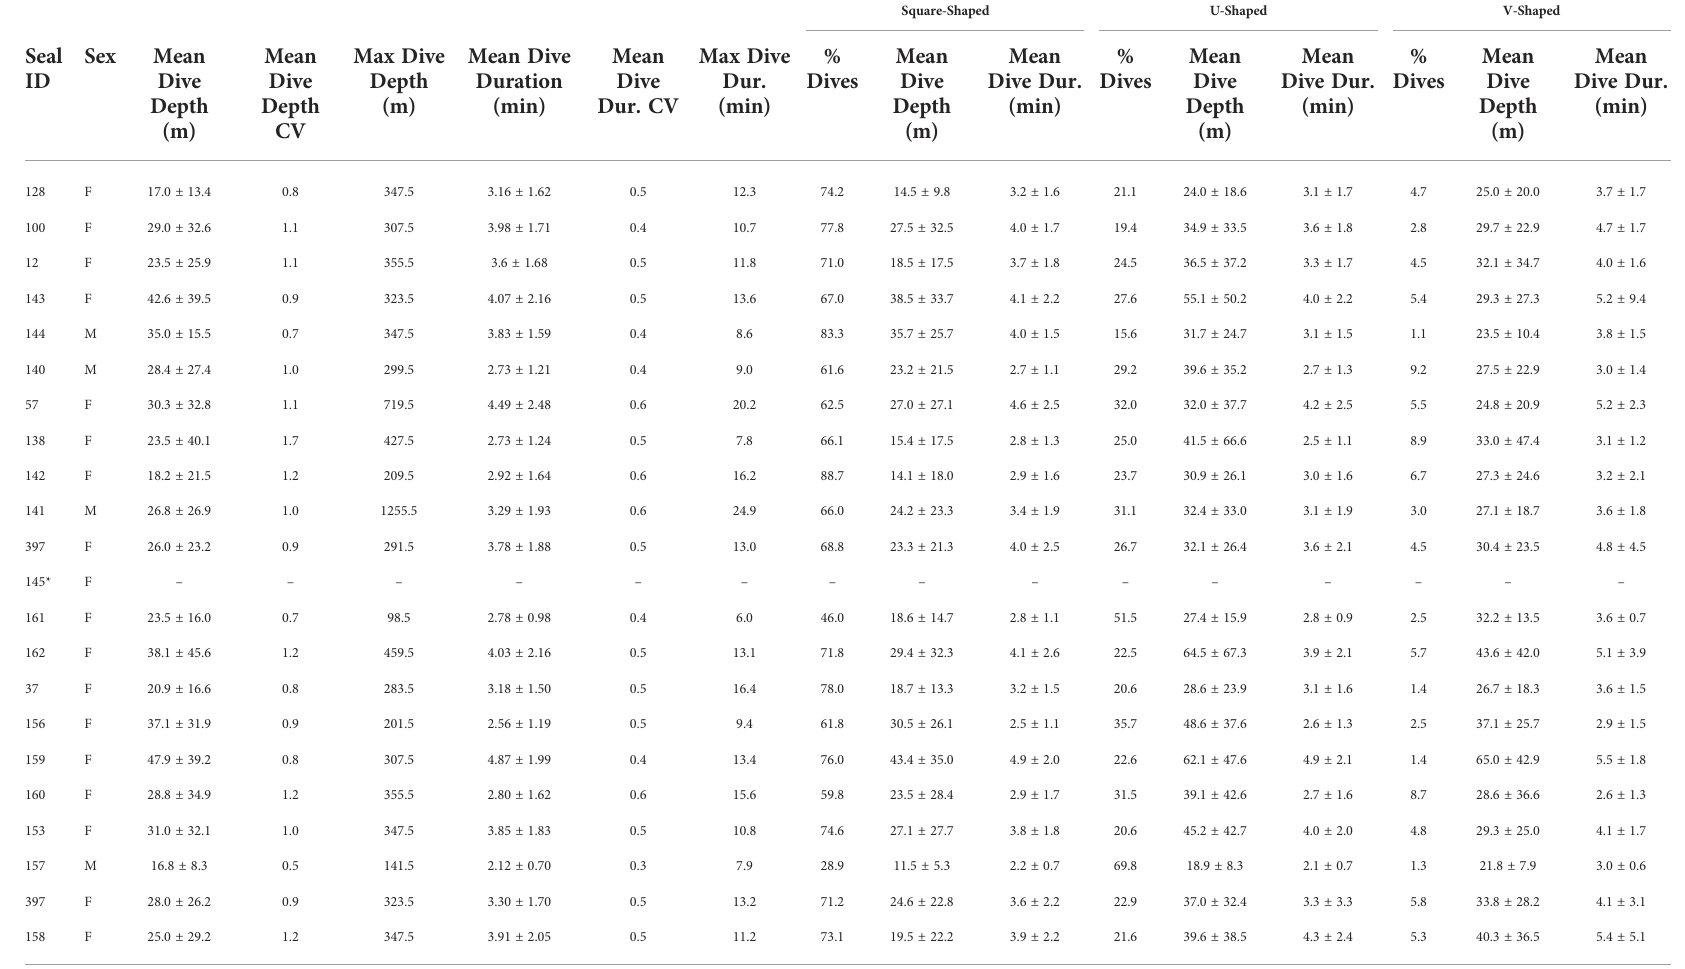
Square-Shaped U-Shaped